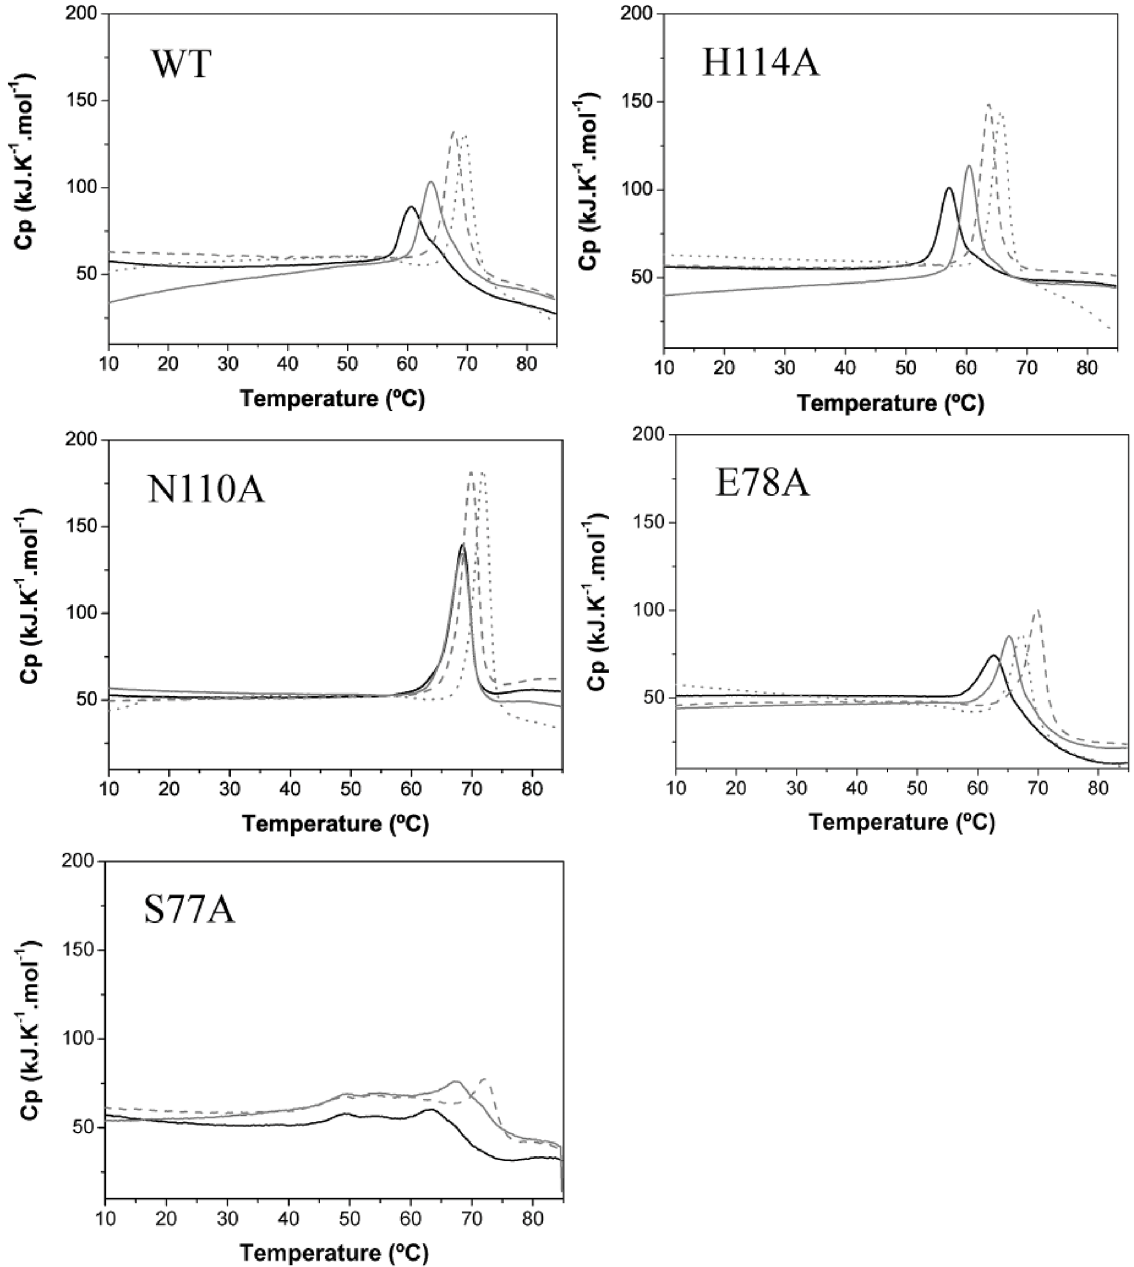
Fig 4. Thermal denaturation followed by DSC of TtgR WT and variants (TtgR H114A , TtgR N110A , TtgR E78A and TtgR S77A ) in the presence and in the absence of ligands (black solid lines free; grey solid lines 250 μ M of chloramphenicol; grey dashed lines 250 μ M naringenin; grey dotted lines 250 μ M